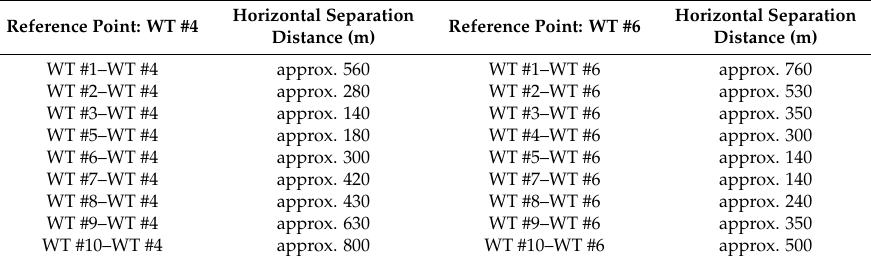
Table 4. Horizontal separation distance between a given WT and the reference point.